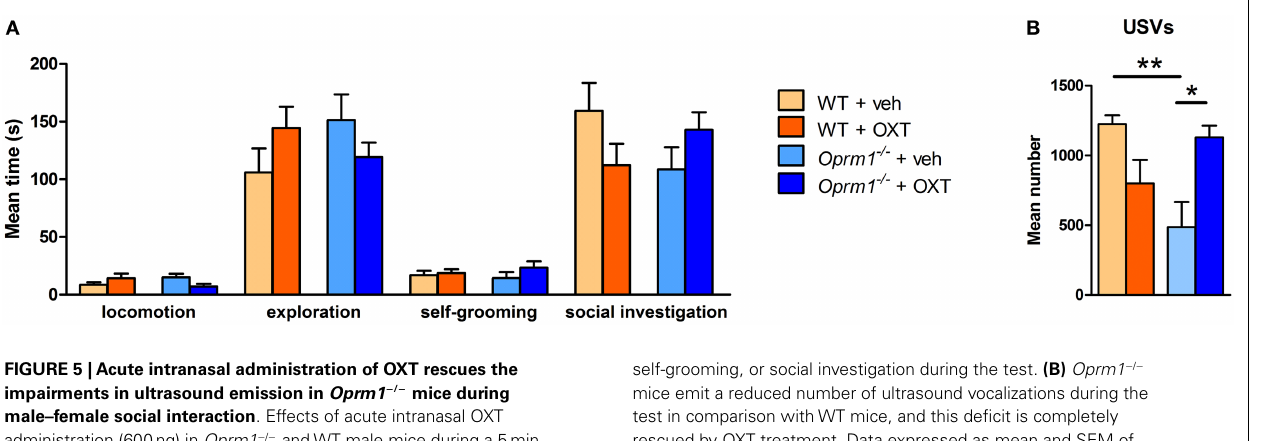
FIGURE 5 |Acute intranasal administration of OXT rescues the impairments in ultrasound emission in Oprm1 − / − mice during male–female social interaction . Effects of acute intranasal OXT administration (600ng) in Oprm1 − / − andWT male mice during a 5min male–female social interaction. (A) Genotype and OXT treatment do not affect the amount of time spent in locomotion, exploration,